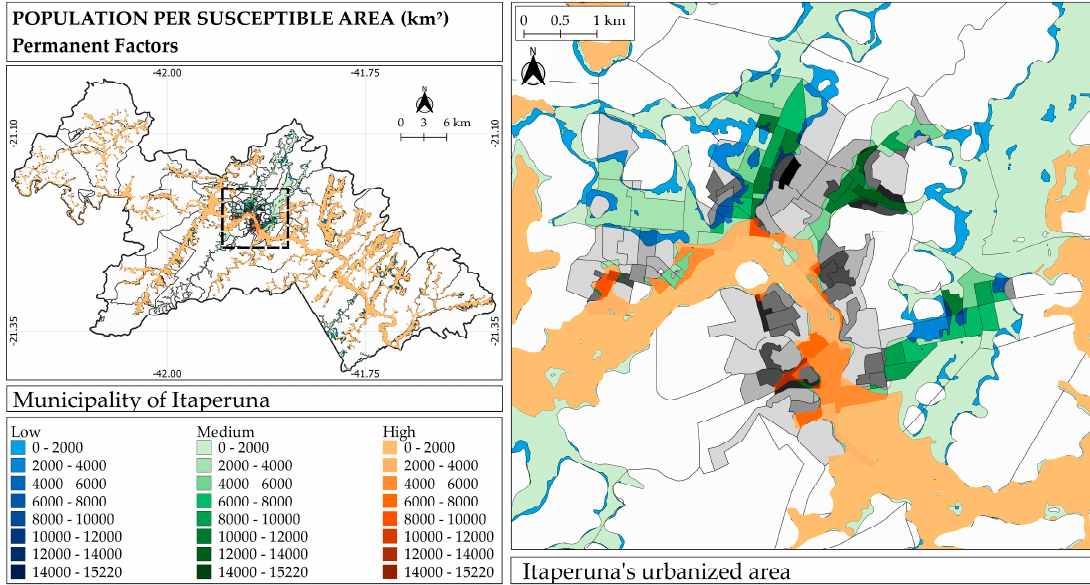
Figure 15. Flood susceptibility map of the municipality of Itaperuna categorized by low (shades of blue), medium (shades of green), and high (shades of red) susceptibility ratings, intersected by the census sector map of population per area released in 2010.